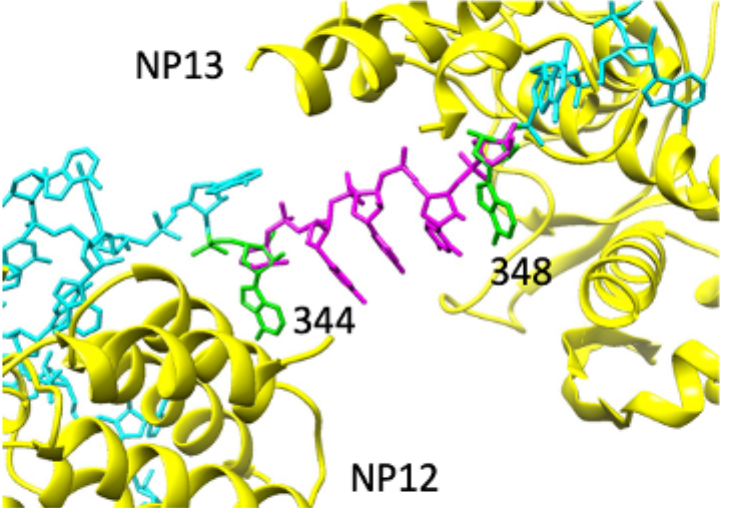
Figure 4. Bridging vRNA between two NP molecules. A five-residue loop (residues 230–234 from T. thermophilus 30S ribosomal subunit, PDB accession code: 1J5E) aligns with the vRNA nucleotides at the junction of the helical and circular suprastructures. The aligned residues of this RNA loop and the NP-bound vRNA (344 and 348) are shown in green, bridging residues are shown in magenta, and NP-associated vRNA residues are shown in cyan. The NP molecules are shown in